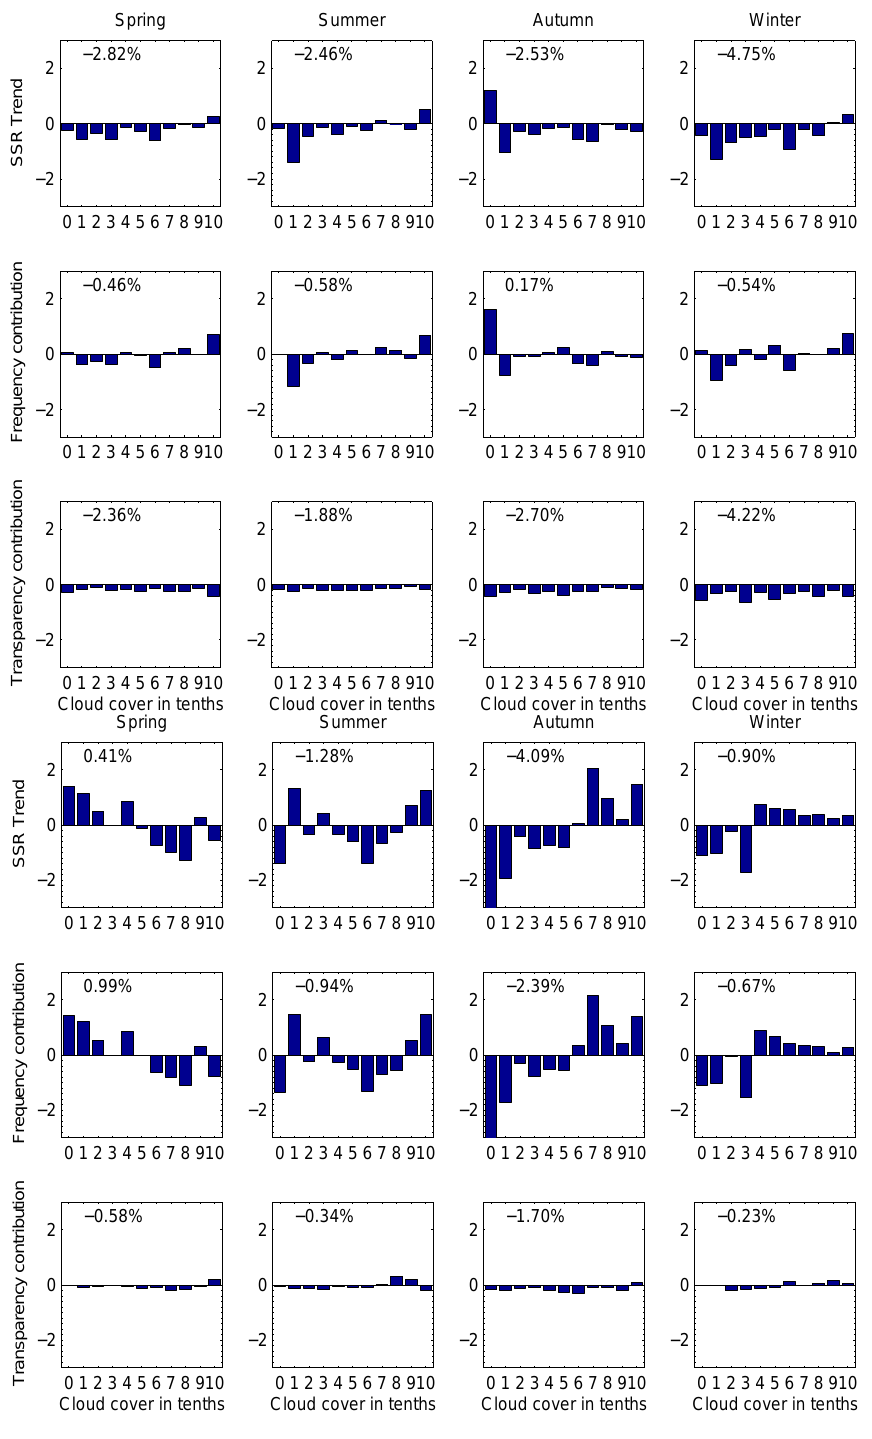
Fig. 6. Seasonal trends in Northwest China during 1961–1990 (upper panel) and during 1991–2005 (bottom panel) expressed as percent of mean SSR per decade for various categories of total cloud cover in tenths (upper); the contribution to the SSR trends attributed to trends in total cloud cover frequency (middle) and the contribution to the SSR trends attributed to trends in the atmospheric transparency (bottom). The values represent the sum of trends in SSR and the total contributions to those trends attributable to trends in total cloud cover frequency and trends in the atmospheric